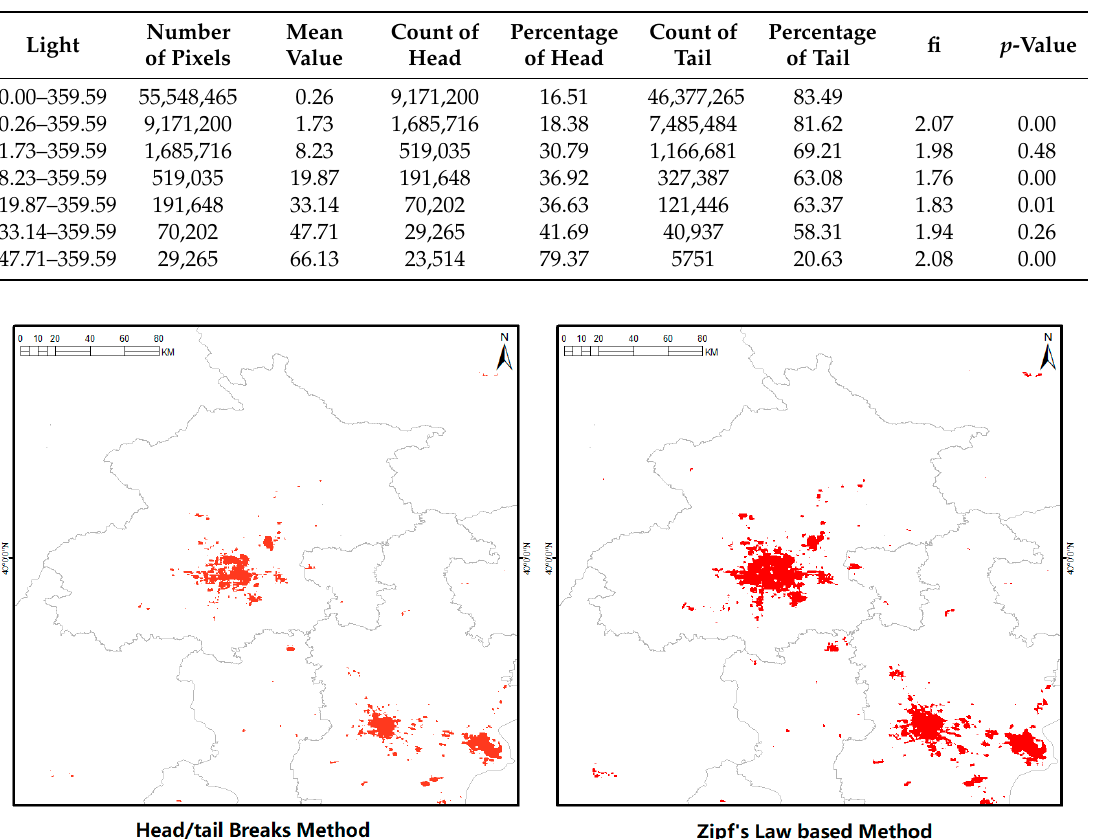
Figure 6. The urban areas extracted from the head/tail breaks method and those derived by the Zipf’s law-based method.